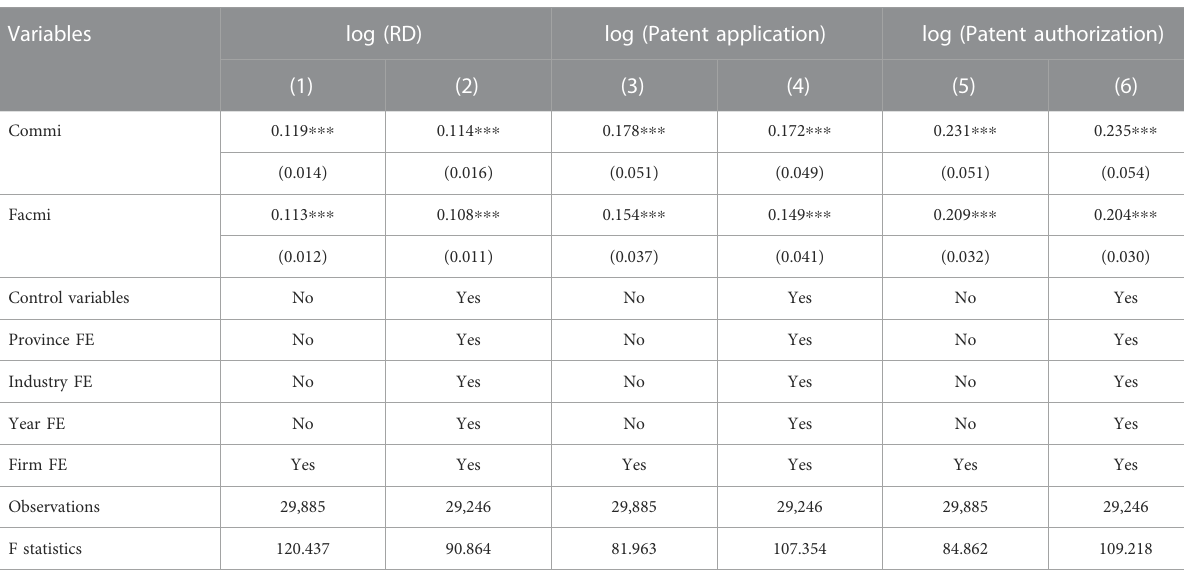
TABLE 5 Robustness